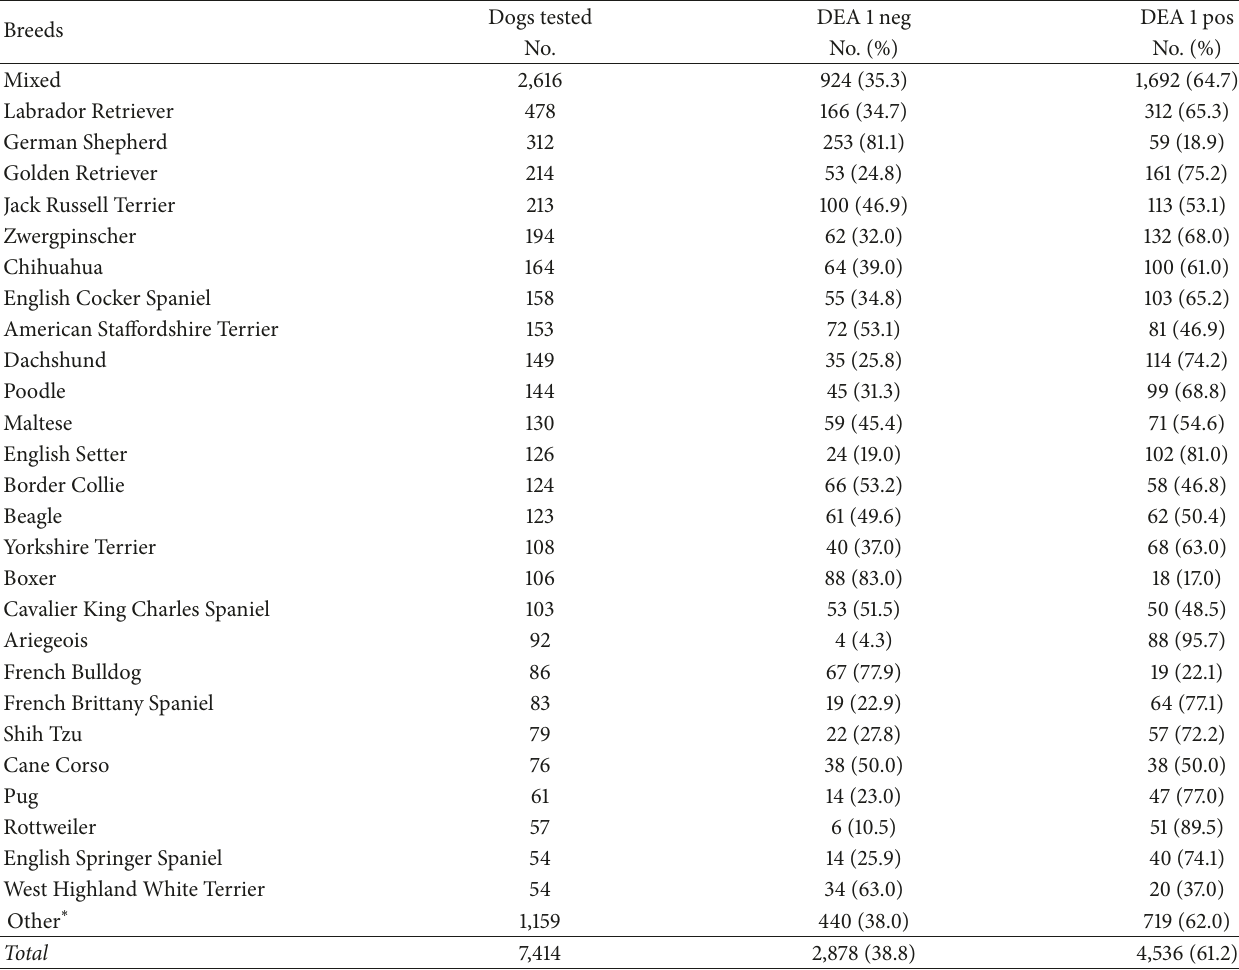
Table 1: Prevalence of DEA 1 negative and positive in the